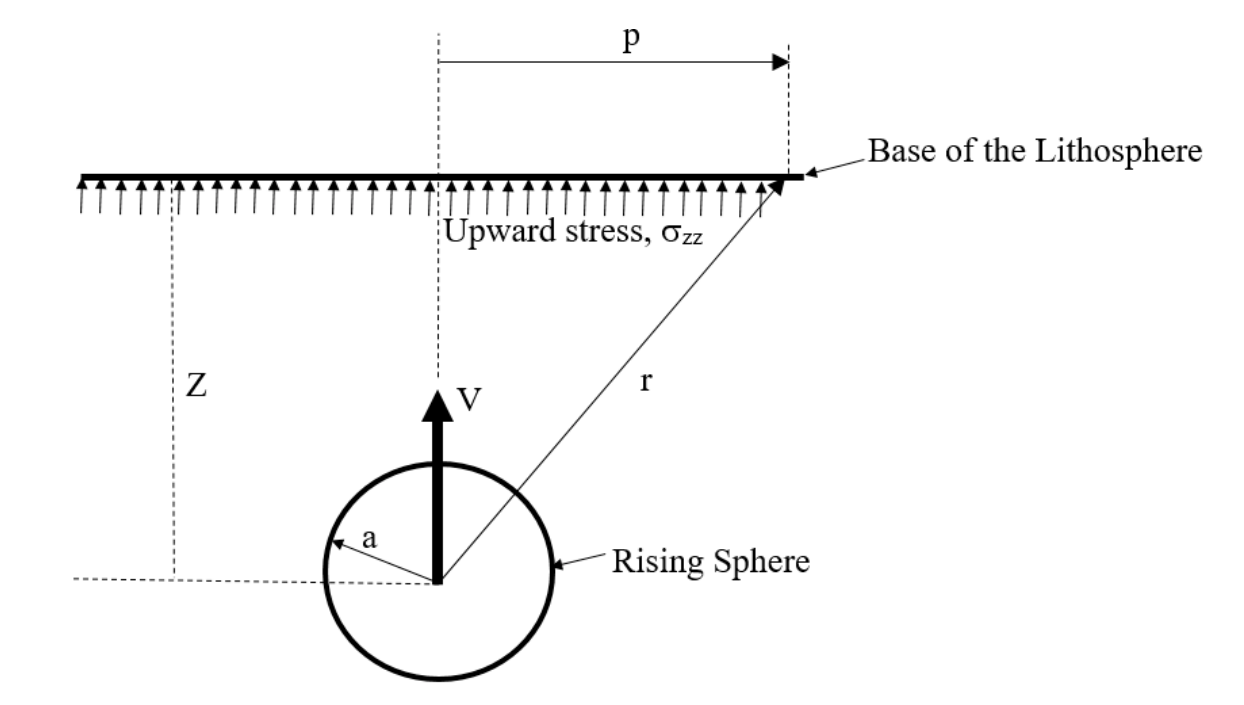
Figure 1. Vertical stress due to mantle plume according to Morgan (1965).